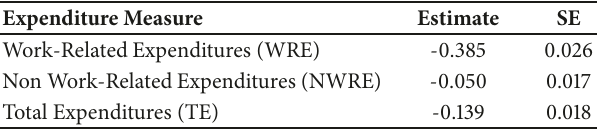
Table 2: Regression estimate for mean regression